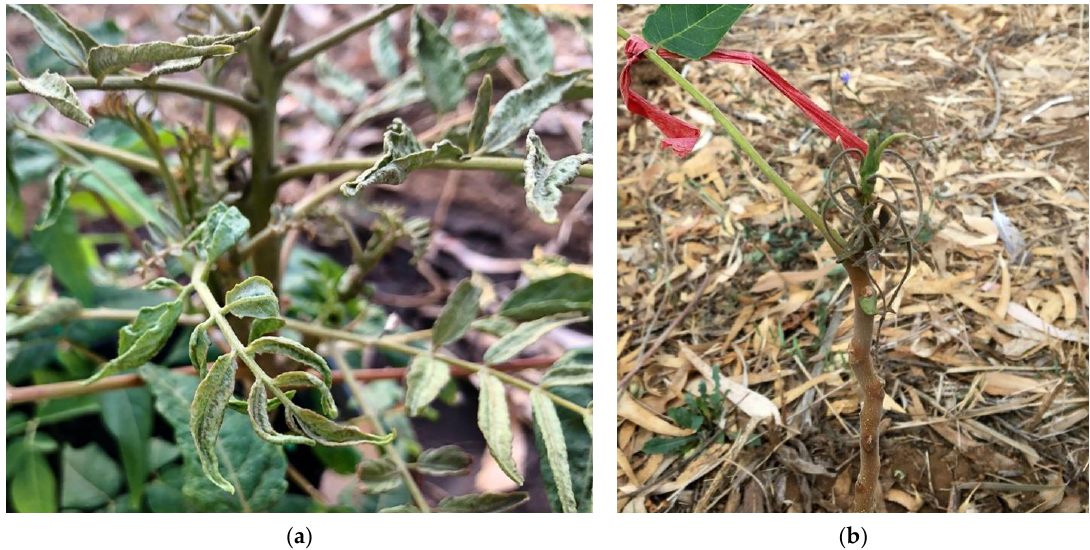
Figure 4. Symptoms of Aculus mosoniensis on Ailanthus altissima : ( a ) leaves strongly deformed 47 days post-inoculation in 2019; ( b ) dried and necrotic apical part 63 days after inoculation in 2020.